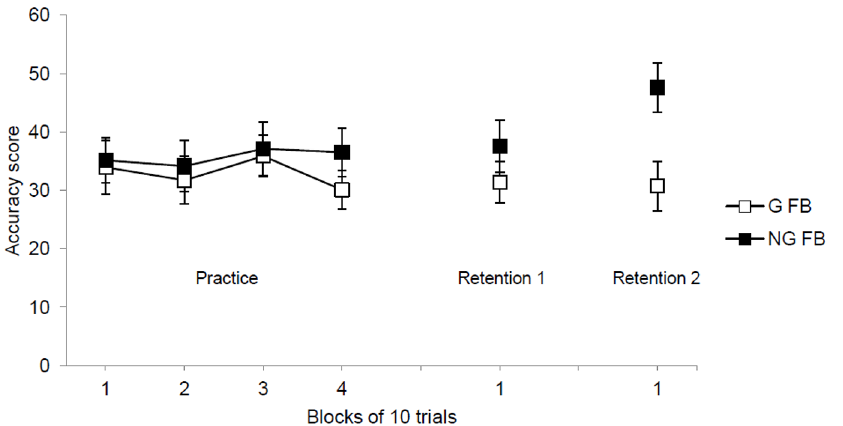
Figure 4. Accuracy scores during practice and retention tests for the G-FB and NG-FB groups. Error bars indicate standard errors.